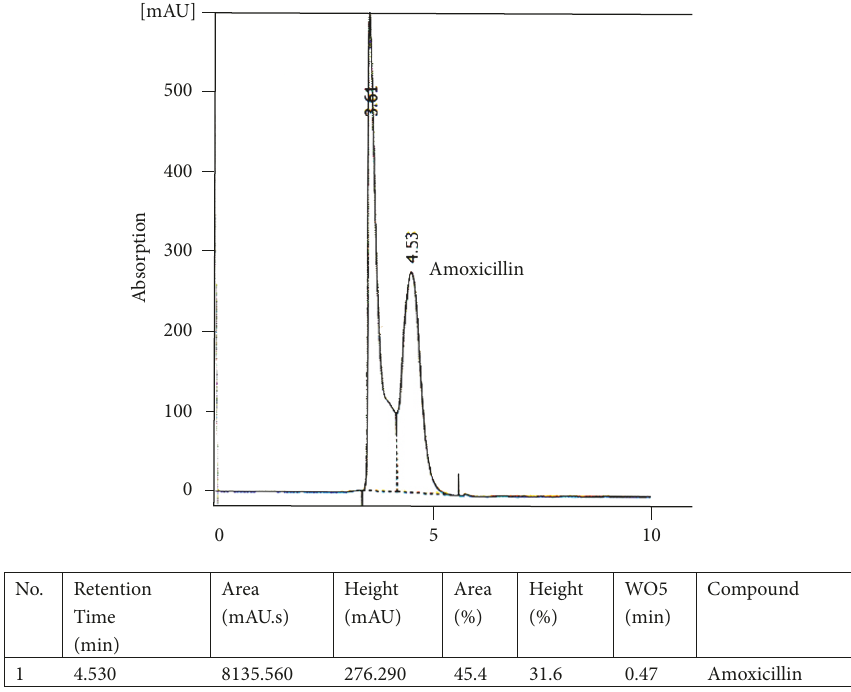
Figure 6: Chromatogram for amoxicillin of Al-Rasheed plant. HPLC-UV analysis showed the presence of amoxicillin in Al-Rasheed water treatment plant, referred by second peak (4.5) during 10min of aqueous